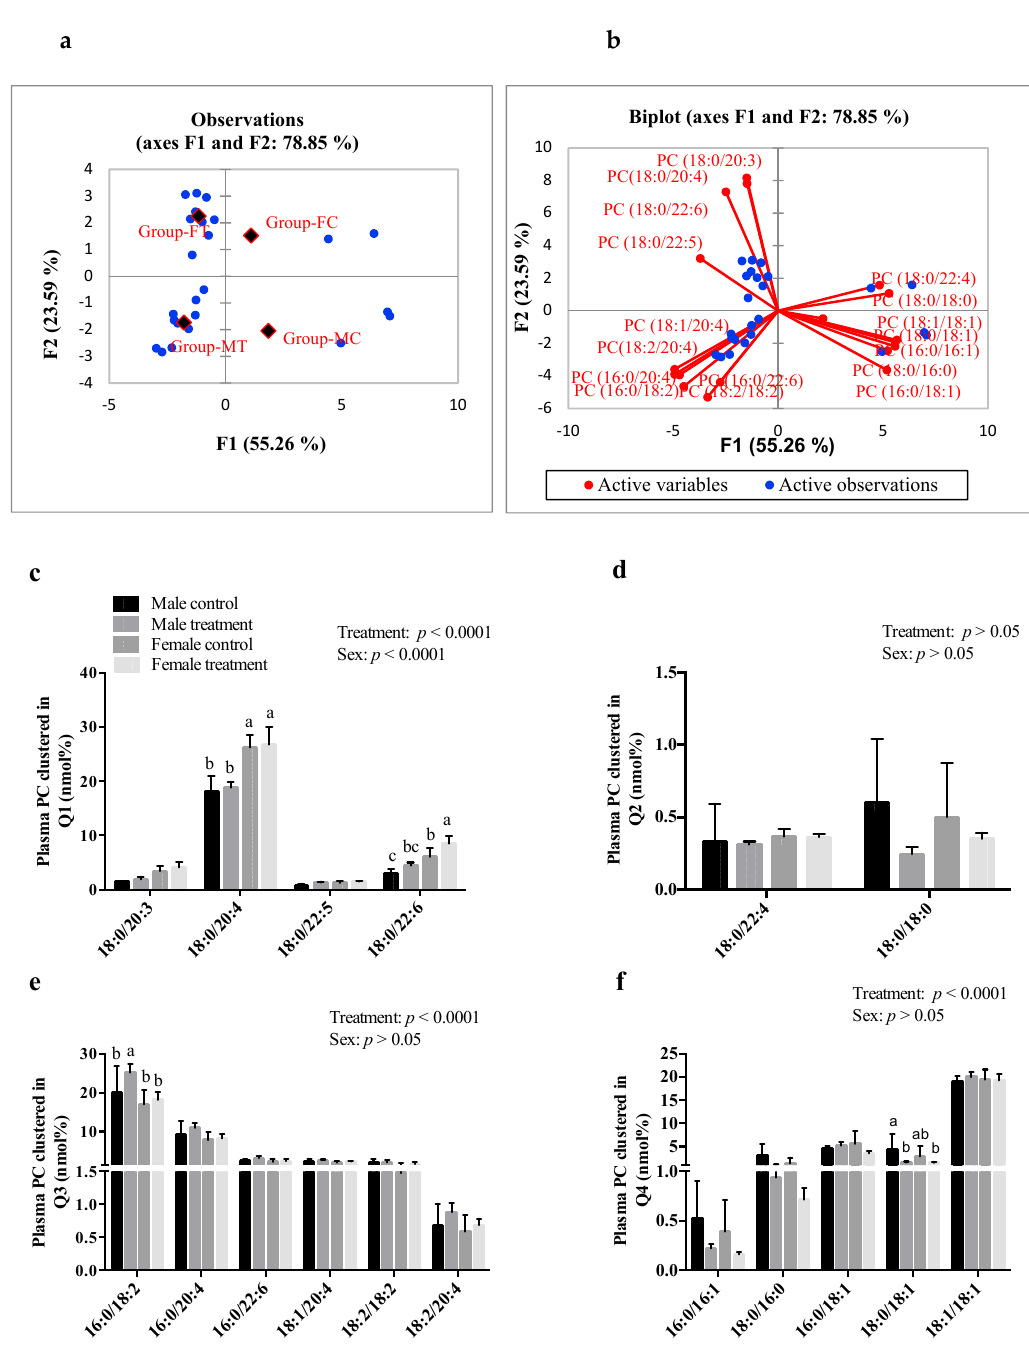
Figure 5. Intraperitoneal administration of SCFAs showed a significant effect on plasma phosphatidylcholine (PC) molecular species in both males and females. Principal component analysis showing ( a ) observation chart and ( b ) biplot of PC species clustered in: ( c ) Q1—quadrant 1, ( d ) Q2—quadrant 2, ( e ) Q3—quadrant 3, and ( f ) Q4—quadrant 4. Data were analyzed using multivariate analysis and two-way ANOVA followed by Tukey’s post hoc test. All data are expressed as mean ± SD. Different superscripts indicate significant difference amongst groups; p < 0.05 was considered significant ( n = 6). SCFAs— short-chain fatty